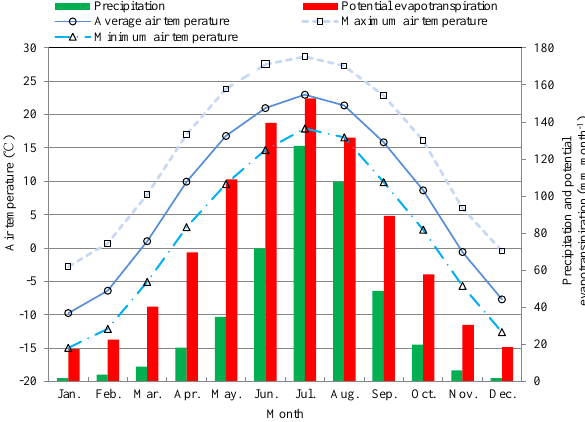
Figure 3. Monthly average precipitation, potential evapotranspira- tion, and air temperature during 1961–2008 in the Miyun Reservoir